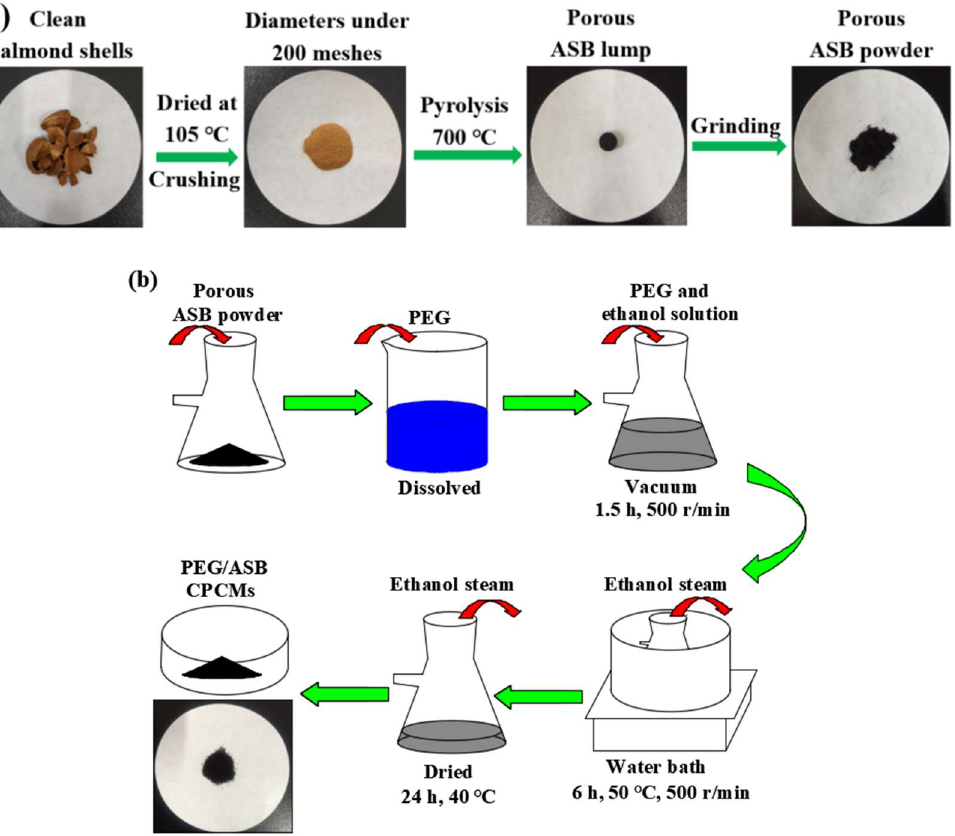
Figure 12. Schematic illustration of ASB preparation ( a ) and PEG/ASB CPCMs preparation ( b ).